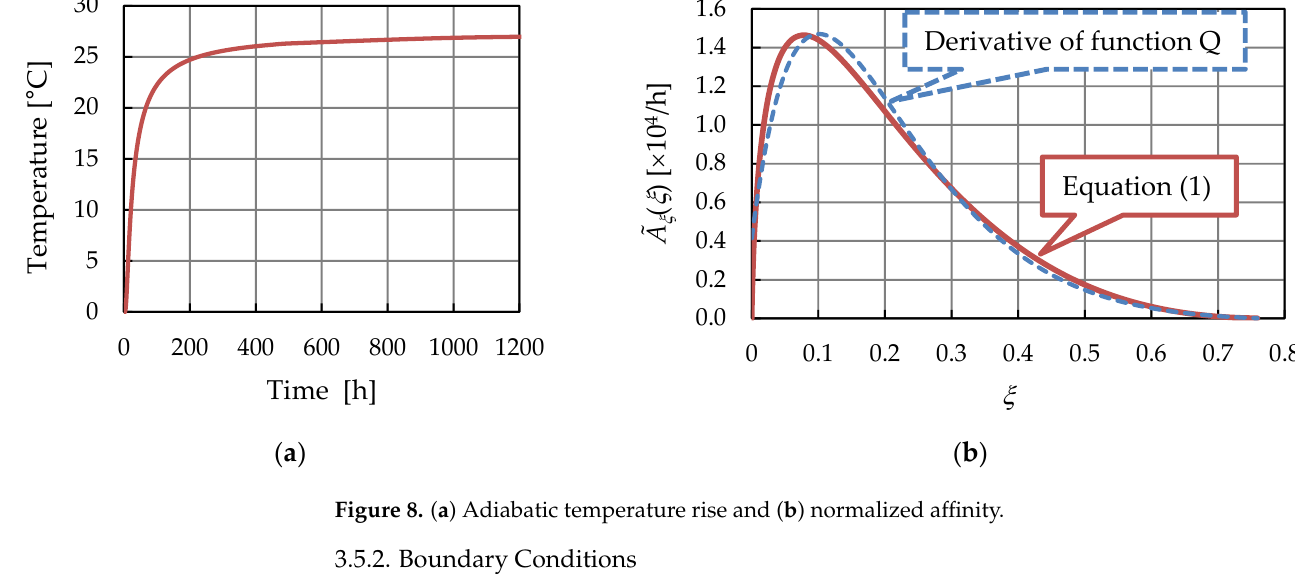
Figure 8. ( a ) Adiabatic temperature rise and ( b ) normalized affinity.